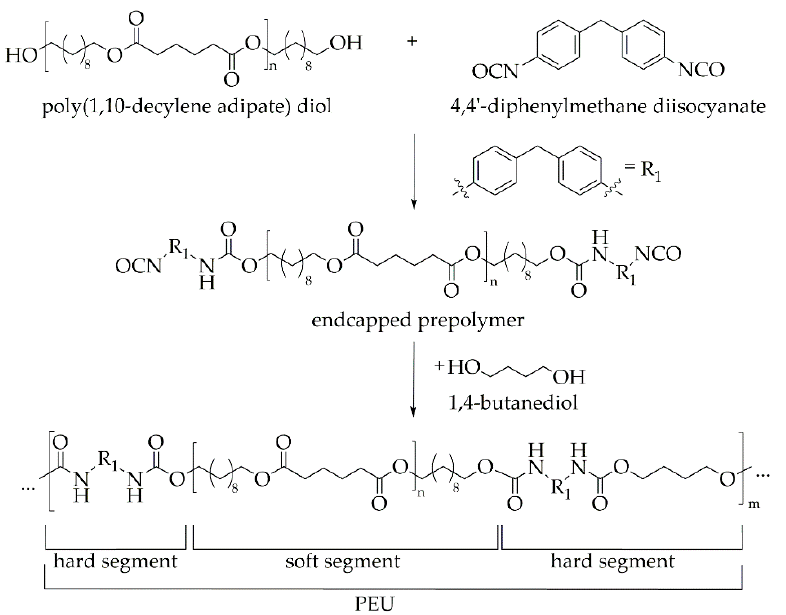
Figure 3. Synthesis of poly(1,10-decylene adipate) diol (PDA)-based polyester urethane (PEU) via polyaddition reaction using the prepolymer method.